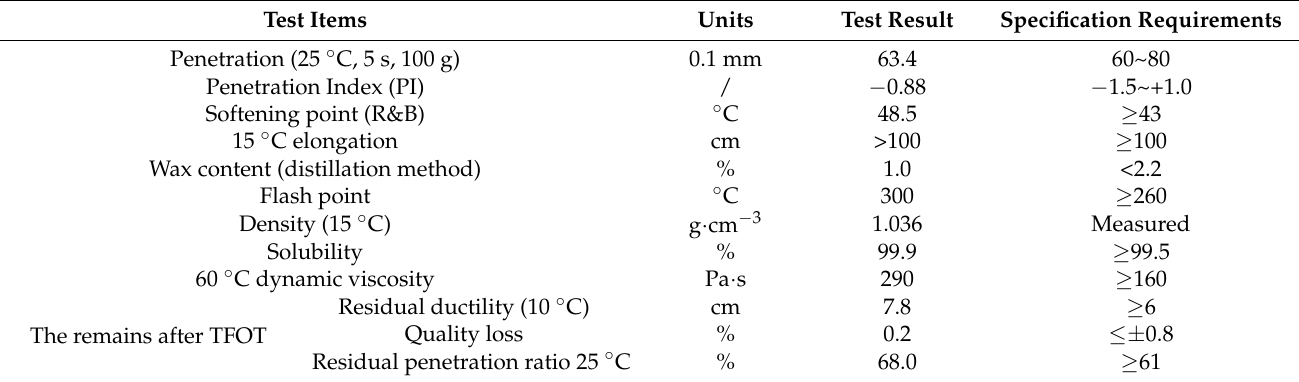
Table 11. Technical indices of the Pen70 asphalt.